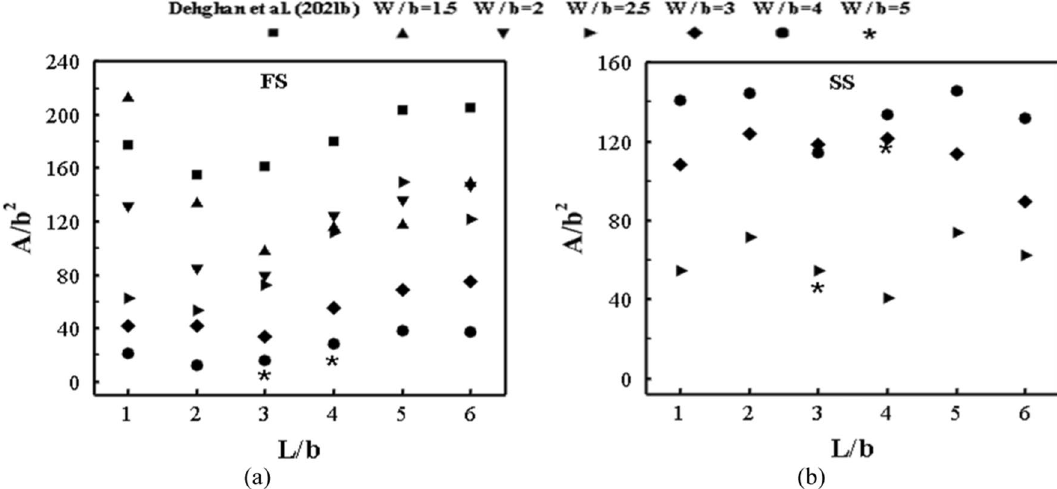
Fig. 4 Values of the area of scouring cavities created surrounding the rectangular piers and collars